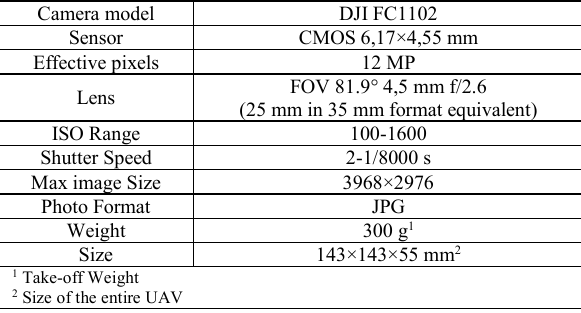
Table 1. Principal specification of the DJI Spark.